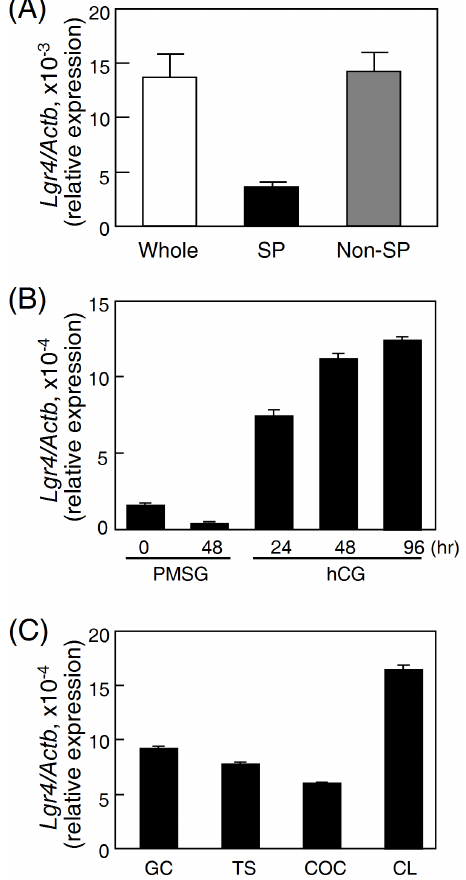
Figure 4. Expression of Lgr4 in the postnatal gonads. (A) Comparison of Lgr4 expression in different testicular cell types. The whole testes from mice at 7 days postnatal and the isolated spermatogonia (SP) and non-spermatogonia (non-SP) were used for real-time quantification of the Lgr4 expression levels. (B) Female rats at 26 d of age were treated with PMSG, followed 48 h later by hCG for different intervals. The ovaries at indicated intervals were harvested for real-time quantification of the Lgr4 expression level. (C) Comparison of Lgr4 expression in different ovarian cell types by real-time PCR quantification. Granulosa cells ( GC ), theca shells ( TS ), and cumulus- oocyte complexes ( COC ) were isolated from rat ovaries (26 days old), whereas corpora lutea ( CL ) were obtained from PMSG-primed rats at 72 h after hCG treatment. Data were normalized using b -actin levels and are expressed as the mean 6 S.D.